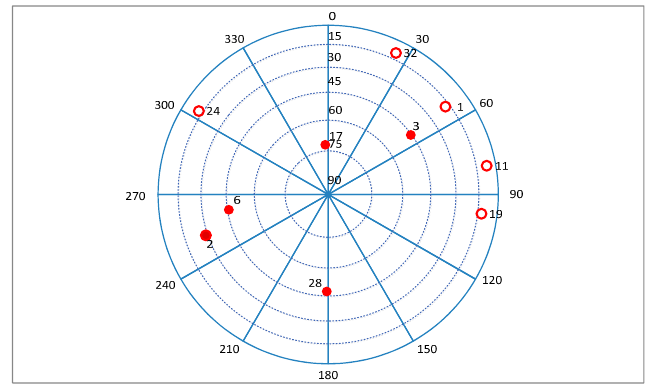
Figure 26. Sky plot of the satellites in field test.